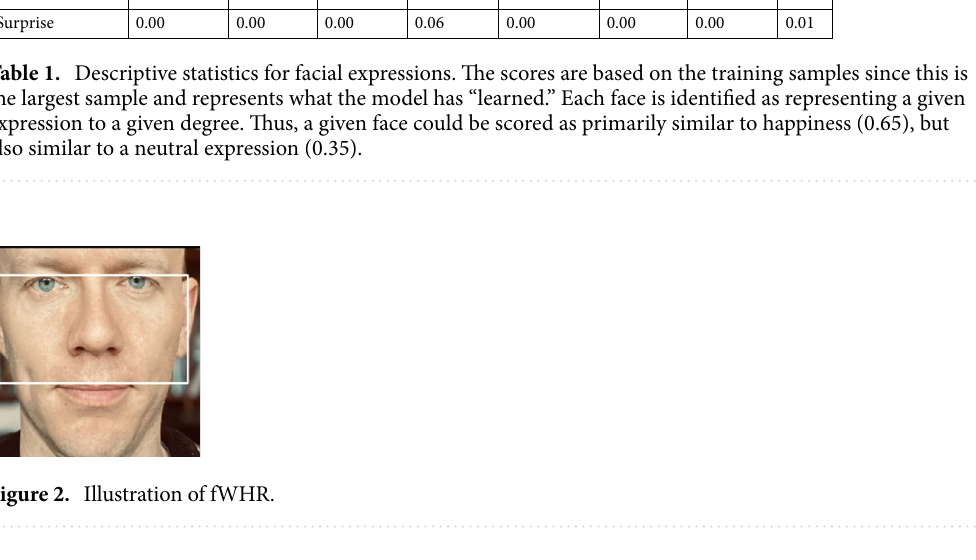
fWHR scores are obtained by dividing the bizygomatic breadth (the length of the white box) by the distance between the top eyelid and the upper lip (the height of the white box) 28 . Male masculinity scores in the sample averaged 1.96 [ SD = 0.16].